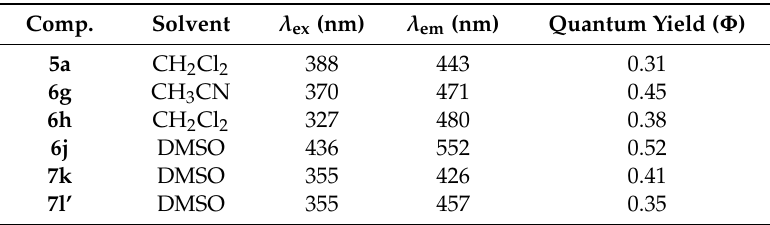
Table 1. Fluorescent properties of the typical structures a .